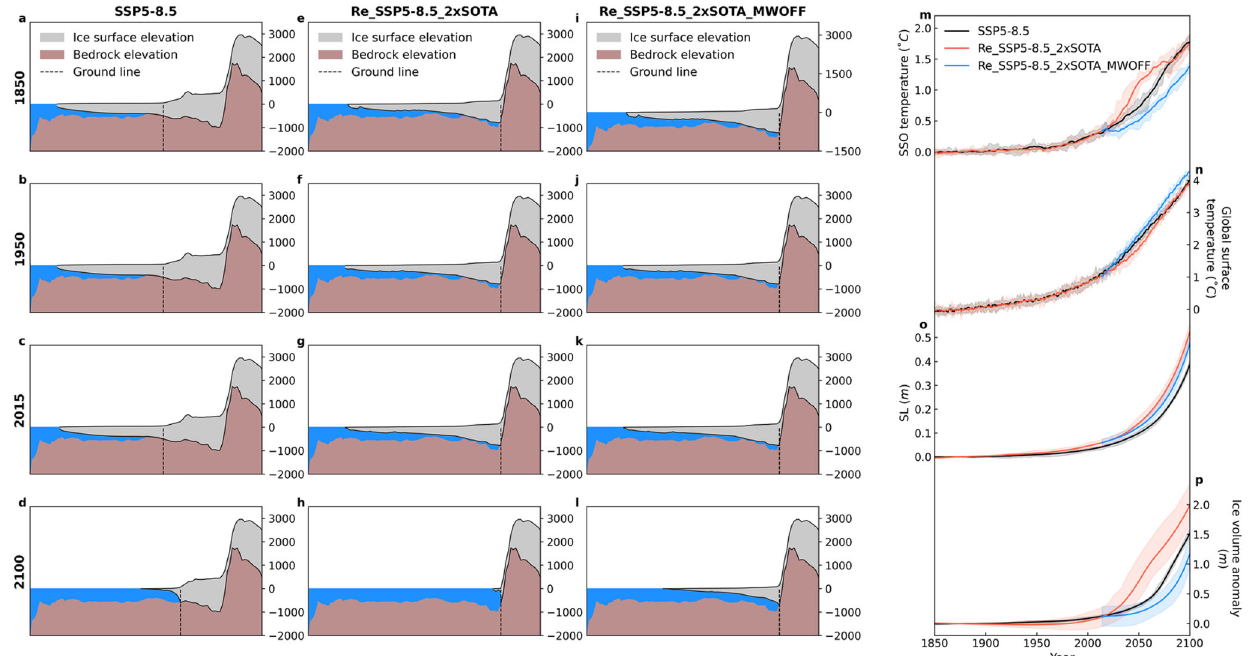
Fig. 6 | Transections of the Antarctic Ross ice-shelf, and global temperature and SL.a – l Transects ofAntarcticRoss-ice-shelfsimulatedin ( a – d ) SSP5-8.5,( e – h ) Re_SSP5-8.5_2xSOTA and ( i – l ) Re_SSP5-8.5_2xSOTA_MWOFF experiments in 1850, 1950, 2015and 2100 CE.Dashedlinesindicate groundinglines. m – p Time series of annualanomalies (relative to the 1850 – 1900CE mean) of ( m ) subsurfaceSouthern